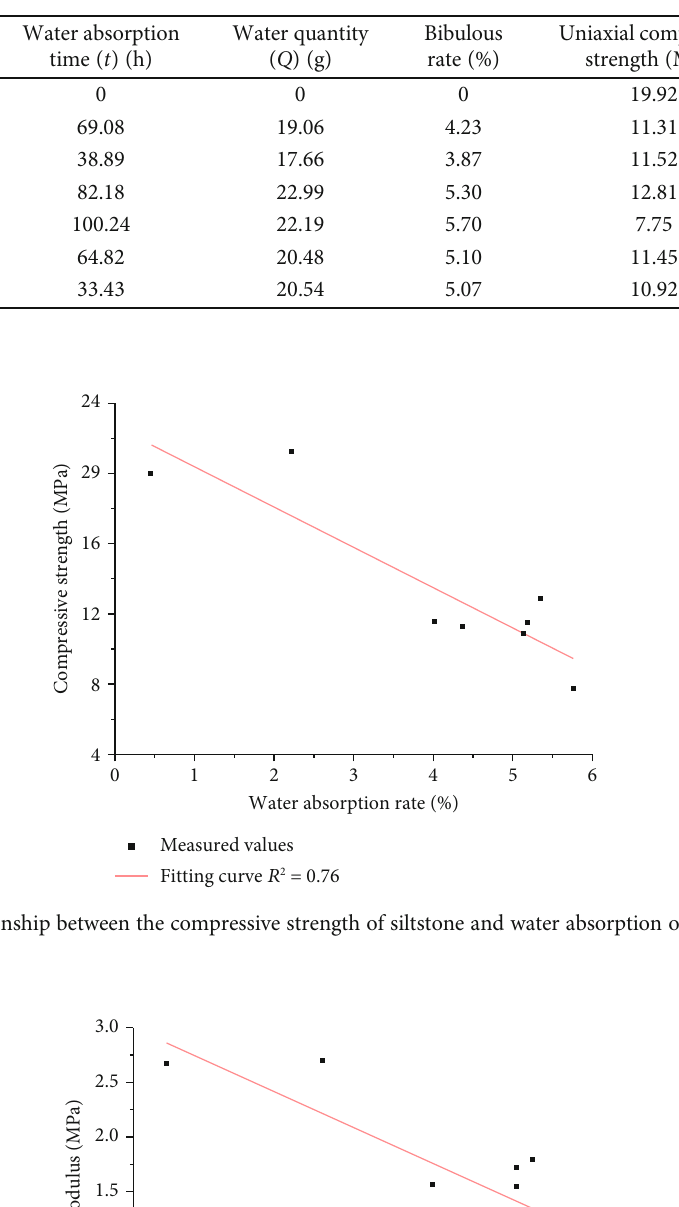
Table 3: Test results of strength softening of siltstone.